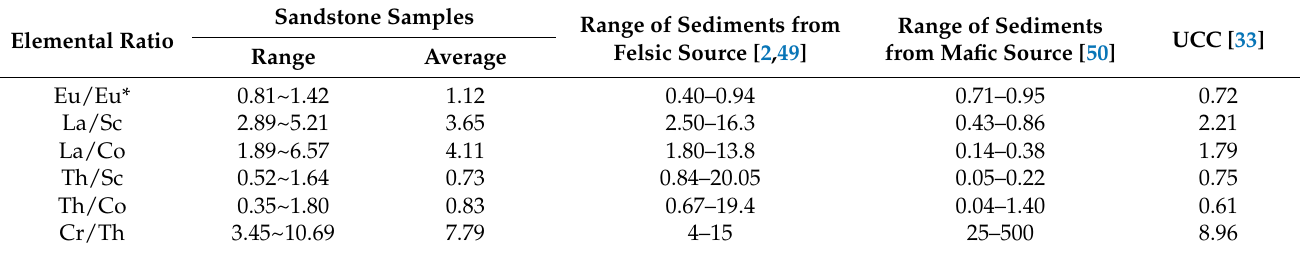
Table 4. Comparison of characteristic parameters of trace elements in sandstones between the Zhiluo Formation and different source